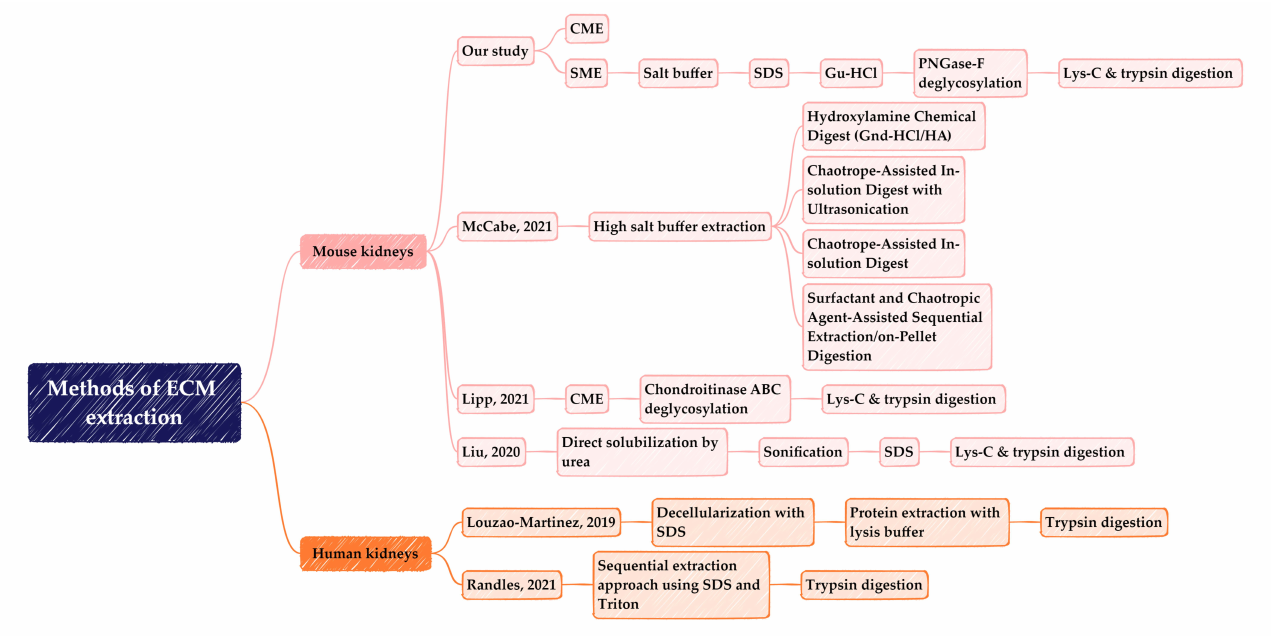
Figure A1. Comparison of the methods of extraction of ECM proteins from mouse and human kidneys